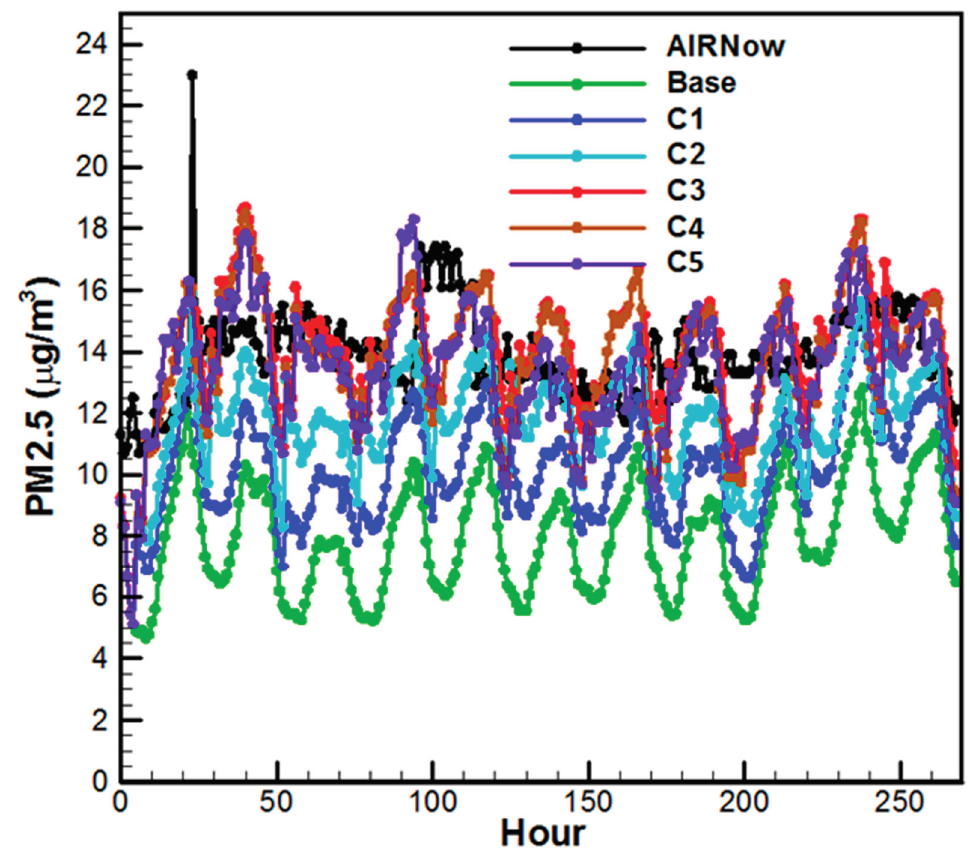
Figure 4. Comparison of domain-wise hourly surface PM 2.5 concentration with measured values from AIRNow stations—averaging 1100 reporting stations over CONUS for each hour. For the Base Case there is no data assimilation. The other cases invoked OI assimilation previous Case coarse mode AOD from Terra, (C3) add Total AOD from Aqua, (C4) add AIRNow PM 2.5 measurements reported at 12 UTC and invoke OI at 12 UTC, and (C5) add to C3 AIRNow measurements every 6